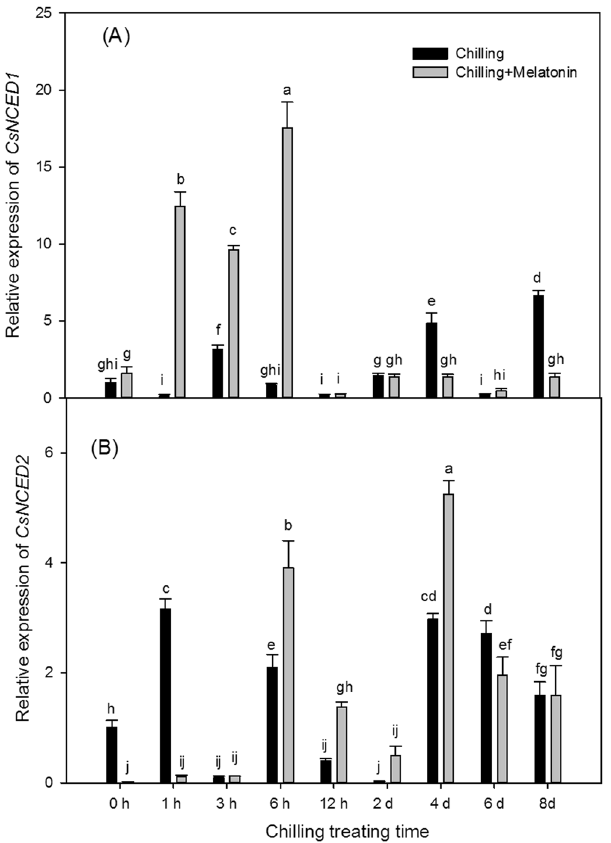
Figure 8. Effects of exogenous melatonin on transcript levels of key genes involved in biosynthesis of abscisic acid (ABA) under chilling stress. ( A ) CsNCED1 , ( B ) CsNCED2 . Control, treating at 28/18 °C; Control + Melatonin, pre-treating with 200 μ M melatonin and treating at 28/18 °C; Chilling, treating at 15/8 °C; Chilling + Melatonin, pre-treating with 200 μ M melatonin and treating at 15/8 °C; Date represent means ± SD of third replicate samples. Different letters indicate a significant difference in a particular series at P < 0.05 according to ANOVA and Duncan’s multiple range